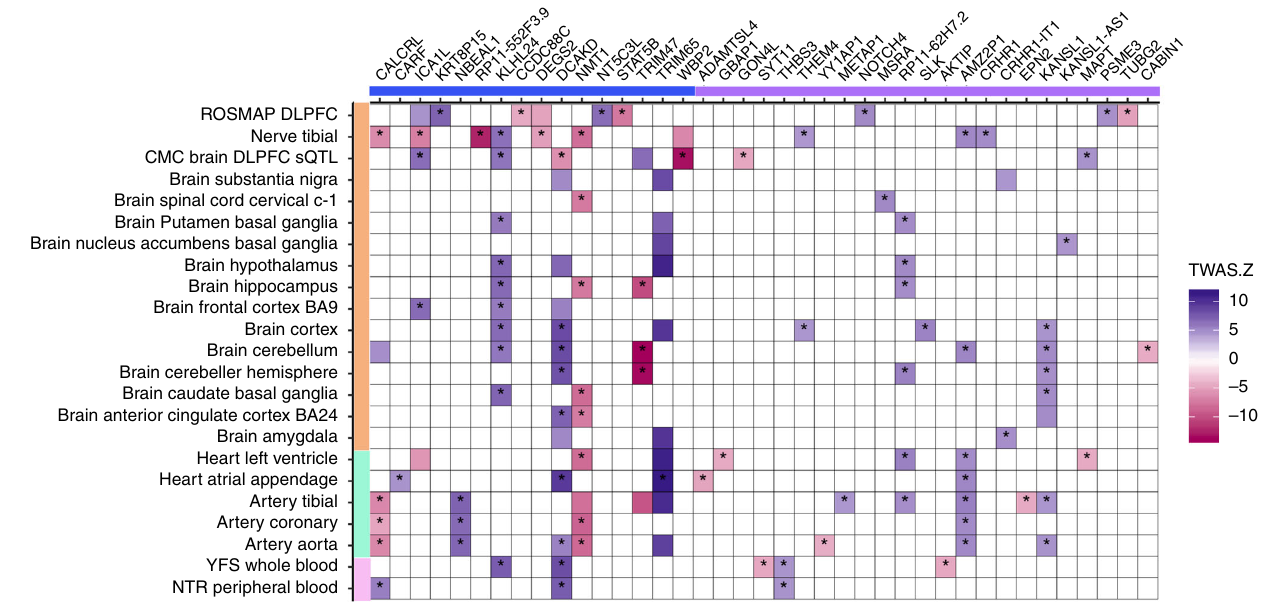
Fig. 5 Transcriptome-wide association study of WMH and gene-expression datasets. Only genes showing signi fi cant colocalization between the eQTL and the WMH risk variant in at least one tissue are shown. Susceptibility genes are depicted on the x-axis (blue: known; violet: novel), with tissue types of gene-expression datasets on the y -axis (orange: brain or peripheral nerve tissue; green: arterial/heart; pink: blood). Blue boxes correspond to WMH risk alleles being associated with upregulation ( + ) of gene expression in the corresponding tissues, while red boxes correspond to WMH risk alleles being associated with downregulation ( − ) of gene expression (color intensity corresponds to the magnitude of gene-expression effect size). Only signi fi cant TWAS associations at P < 1.1 × 10 − 5 are shown. Asterisks denote loci harboring a common causal variant associated with WMH and gene expression with high posterior probability using colocalization analyses (Methods; PP4 ≥ 0.75). ROSMAP religious order study and rush memory and aging project, DLPFC dorsolateral prefrontal cortex, CMC common mind consortium, BA Brodmann area, YFS young Finns study, NTR Netherlands twins